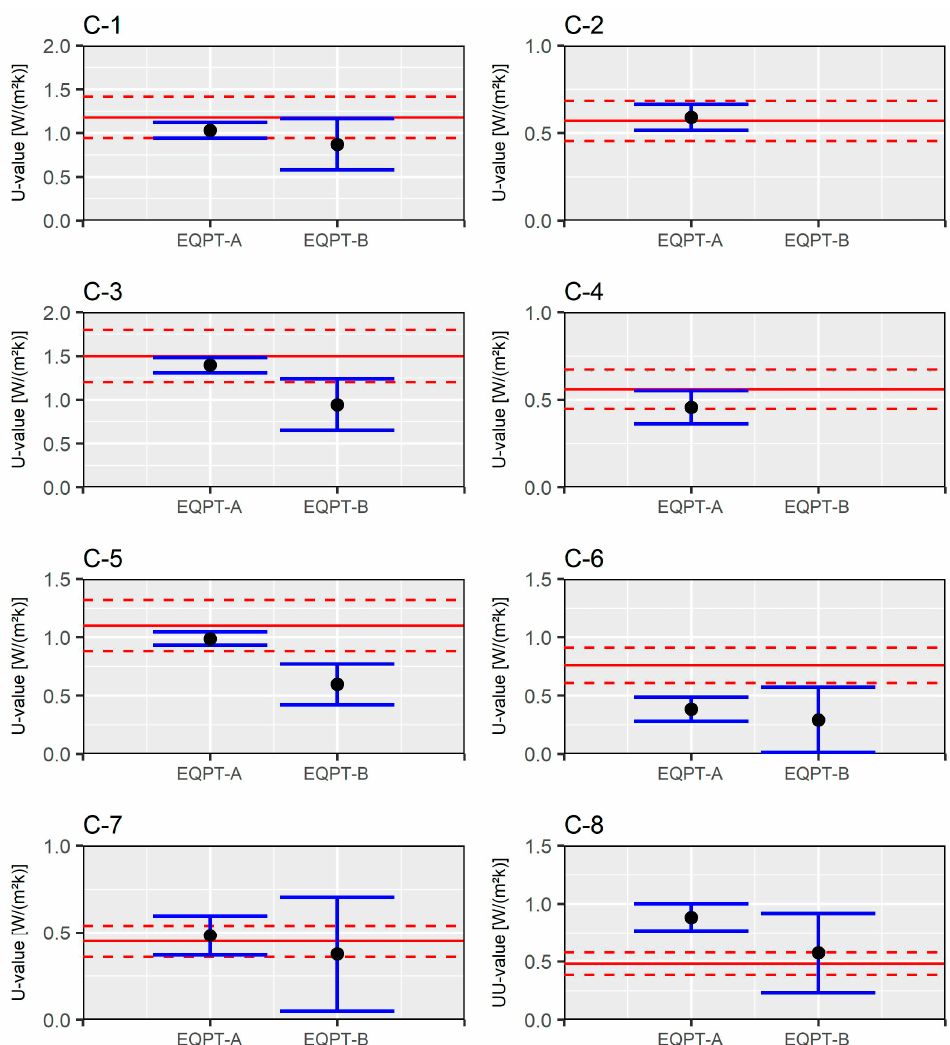
Figure 4. Comparison of the thermal transmittance values obtained for the different case studies. EQPT-A denotes data logger A and EQPT-B indicates data logger B. The estimated value provided in ISO 6946 is represented by the red line [17] using the CCF of Pérez-Bella et al. [38], and the maximum acceptable difference (20%) regarding that value is represented by the dashed line.